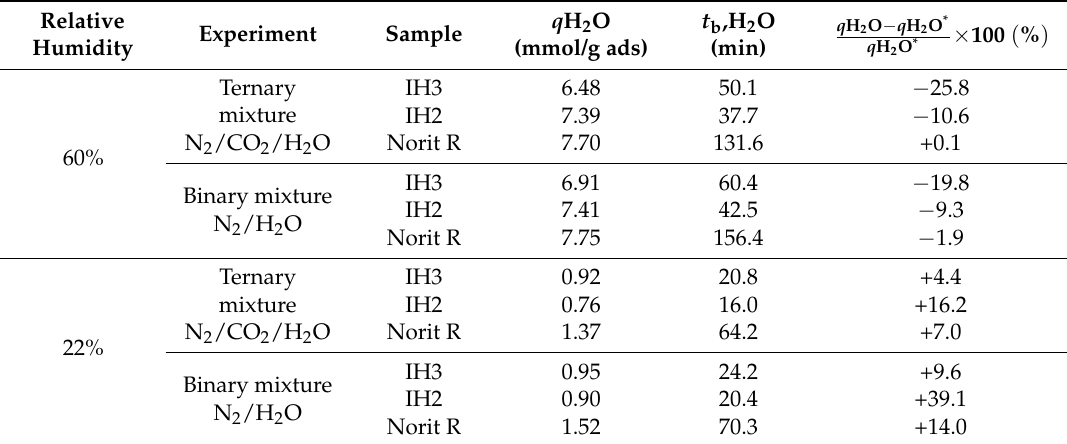
Table 7. Adsorption capacities of water vapor and breakthrough times during non-cyclic experiments at low and high relative